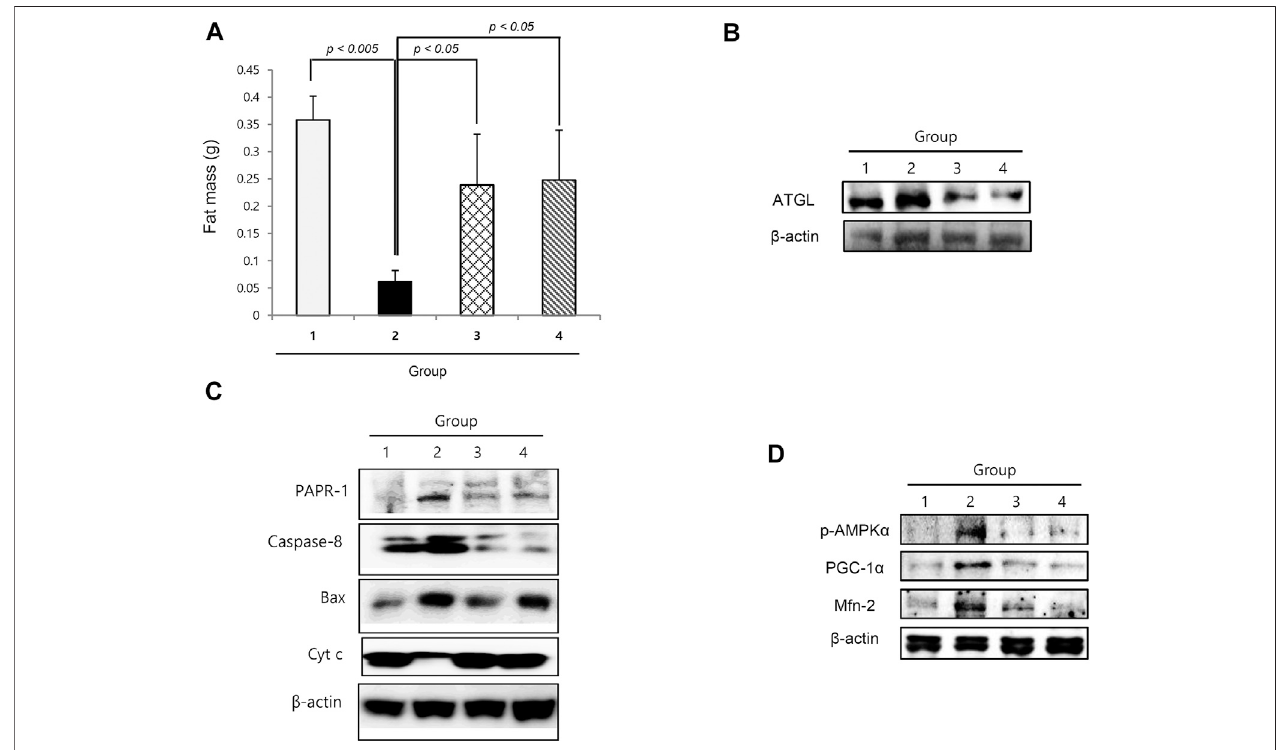
FIGURE 5 | Changes of fat status according to the groups. (A) Epididymal fat mass according to the groups. (B) Western blot for ATGL. (C) Western blot for apoptotic executors according to the groups. (D) Western blot for p-AMPK α , PCG-1 α , and Mfn-2.